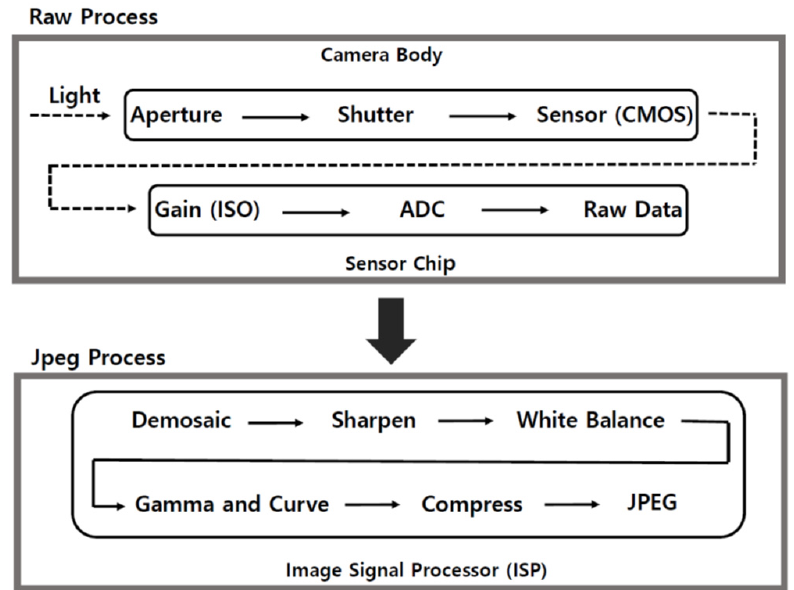
Figure 2. Schematic of the color image pipeline for raw and jpeg image. After the raw data are created, further processes for generating a jpeg digital image are continued. Each stage of the color image pipeline is fairly standard although varying in order or combined according to the manufacturers. images. During the demosaicing process, a Bayer filter is applied to the data received by all the pixels through interpolation. The missing color channels of the raw mosaiced images are estimated from a CFA to reproduce full-color images . This is an essential process for single-sensor digital